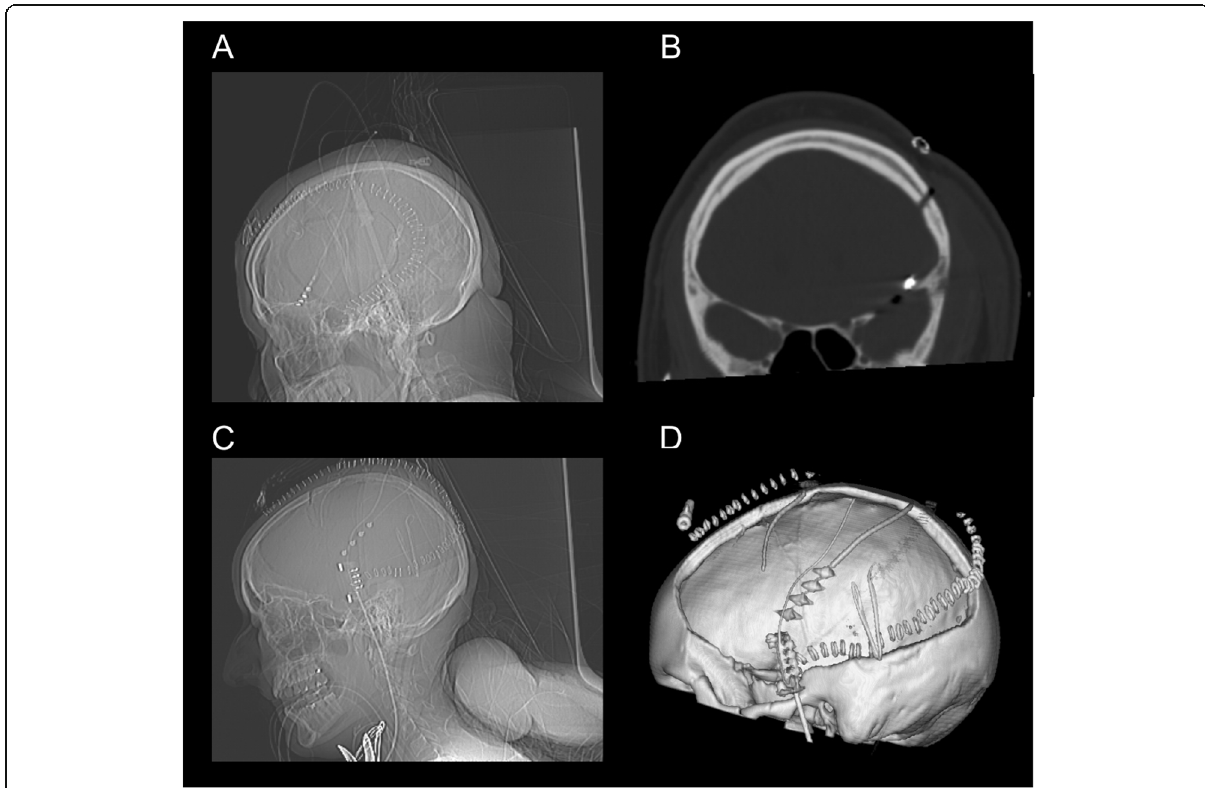
Fig. 3 a Postoperative scout of CT scan with frontal EEG electrodes. b Coronary reconstruction of the CT scan. c Postoperative scout of CT scan with temporal EEG electrodes. d 3D reconstruction of the